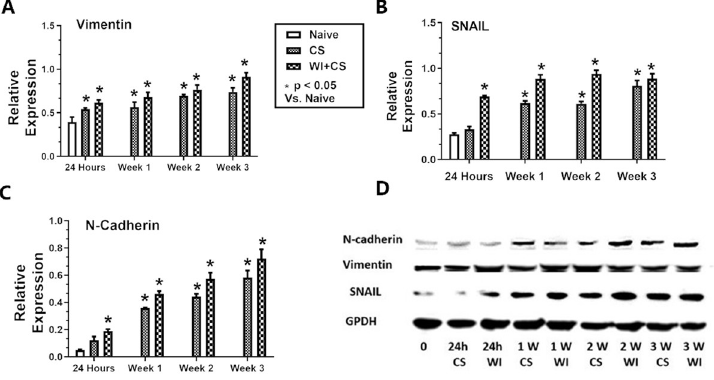
Fig 5. Mesenchymal protein expression profiles on cholangiocytes. Cholangiocyte expression (via western blot) of Vimentin (panel A), SNAIL (panel B), and N-Cadherin (panel-C) in Naive cholangiocytes, from those cold stored for 24 hours (CS), and from those with both 60 minutes of warm ischemia and 24 hours of cold storage (WI+CS). Expression is shown for 24 hours, 1, 2, and 3 weeks from ischemia exposure to staining. Panel D shows an actual chemiluminescent western blot analysis of these proteins and the GAPDH loading control. All samples were loaded at 30 μ g protein per lane. � P < 0.05, values are expressed as mean +/- SD from 5 independent experiments.